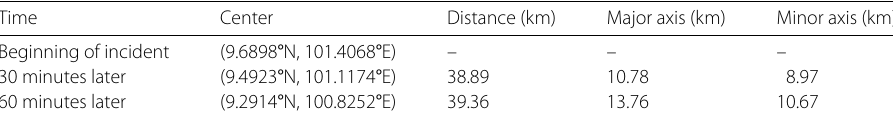
Table 3 The size in ellipse and position of oil slick starting at Platong oil drilling rig at different